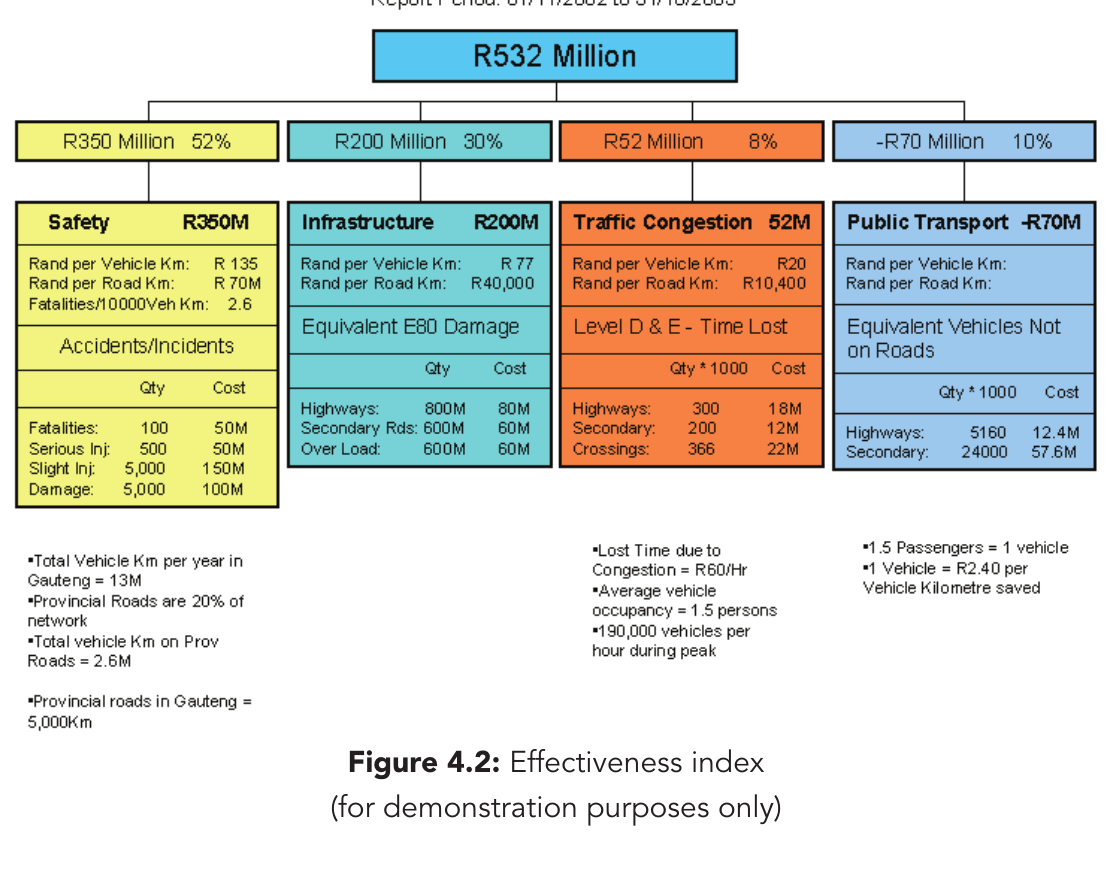
Figure 4.2: Page 2: Effectiveness index (for demonstration purposes only)